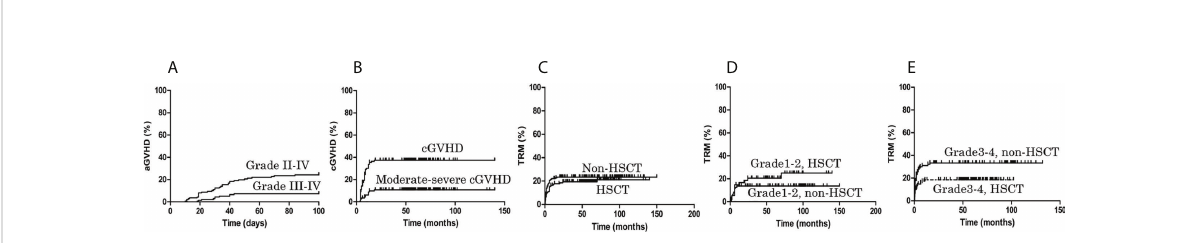
FIGURE 1 The cumulative incidence of graft versus host disease (GVHD) and treatment-related mortality (TRM). (A) In the allo-HSCT group, the cumulative incidence of grades II to IV acute GVHD (aGVHD) on day +100 was 24.27%, and the cumulative incidence of grades III and IV aGVHD on day +100 was 7.41%. (B) The cumulative incidence of chronic GVHD (cGVHD) was 37.40%, and the cumulative incidence of moderate – severe cGVHD was 11.34%. (C) During the follow-up period, TRM in the HSCT and non-HSCT groups was 21.13% and 23.27%, respectively ( P = 0.464). (D) The TRM of grade 1-2 infection in the HSCT and non-HSCT groups was 24.99% and 13.68%, respectively ( P = 0.206). (E) The TRM of grade 3-4 infection in the HSCT group was lower than non-HSCT group (18.54% vs. 33.33%, P = 0.036).